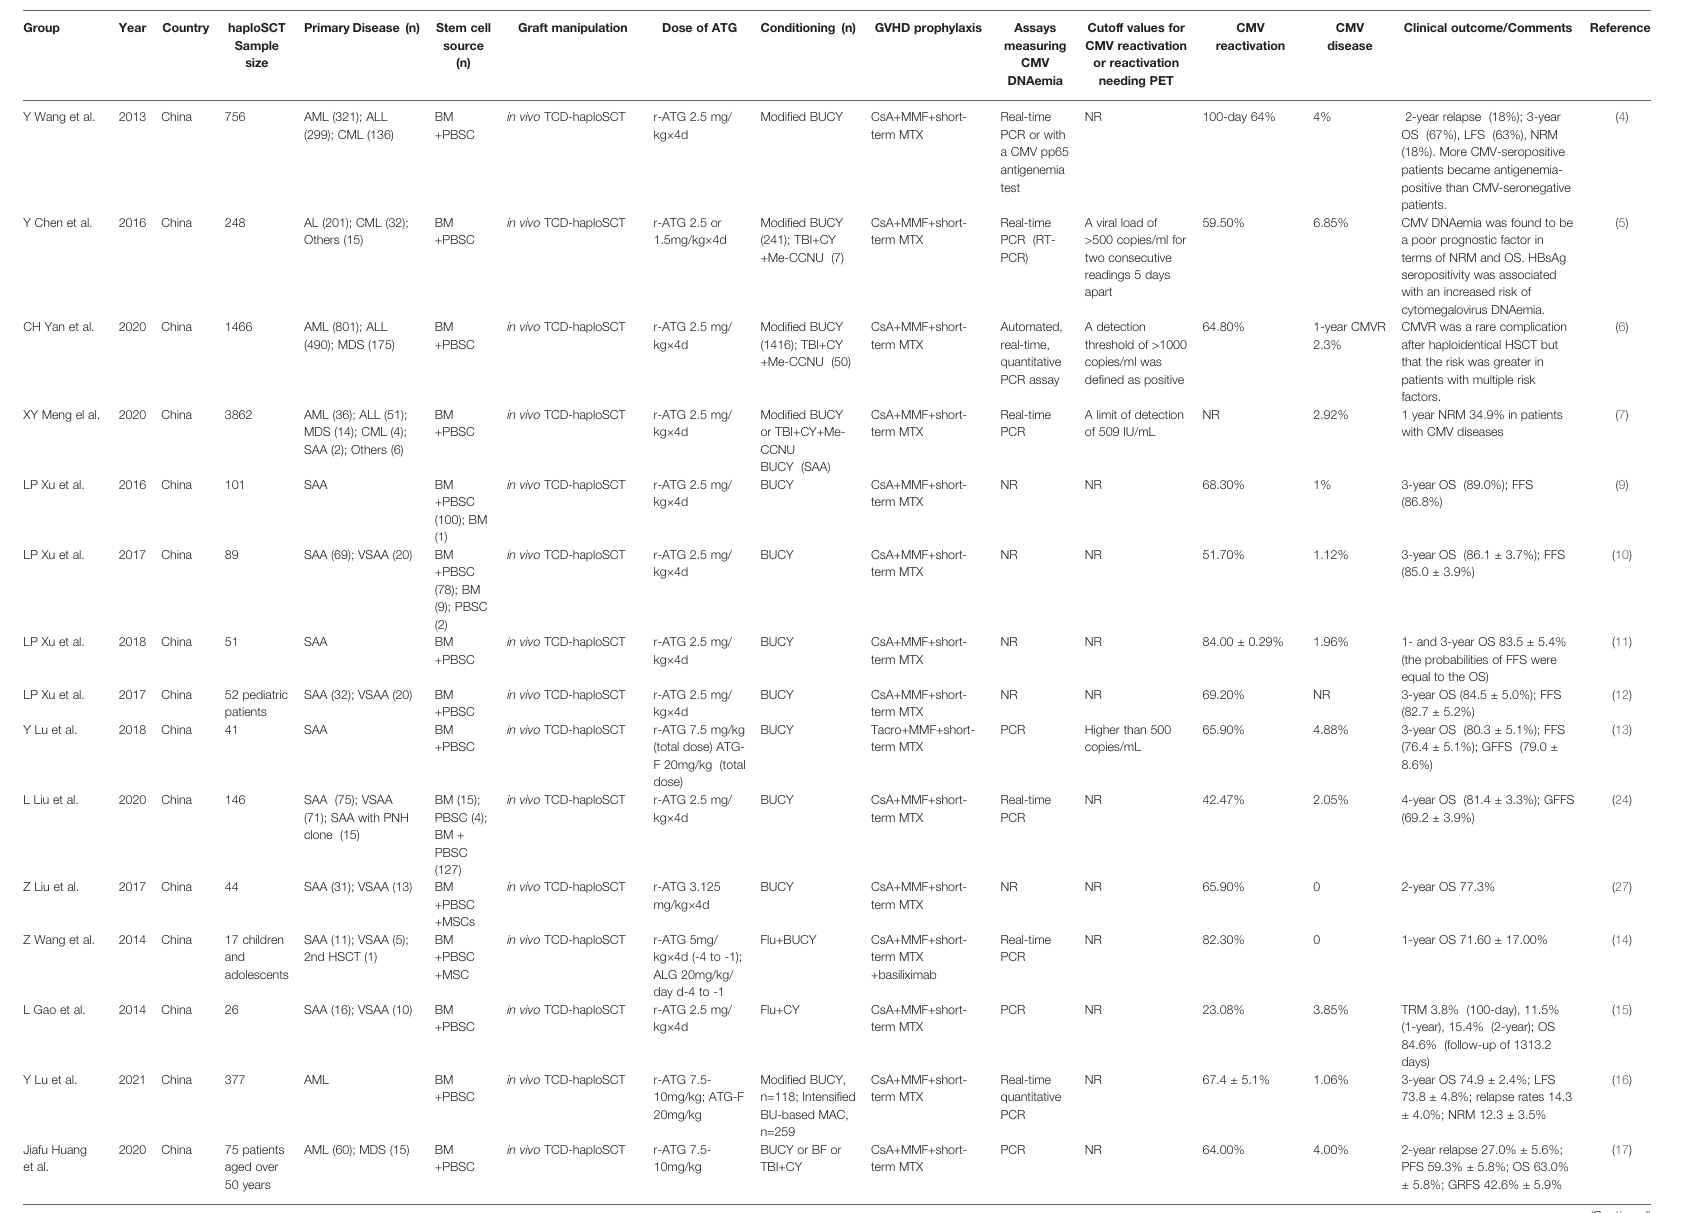
TABLE 1 | Selected reports on CMV infection after haploidentical stem cell